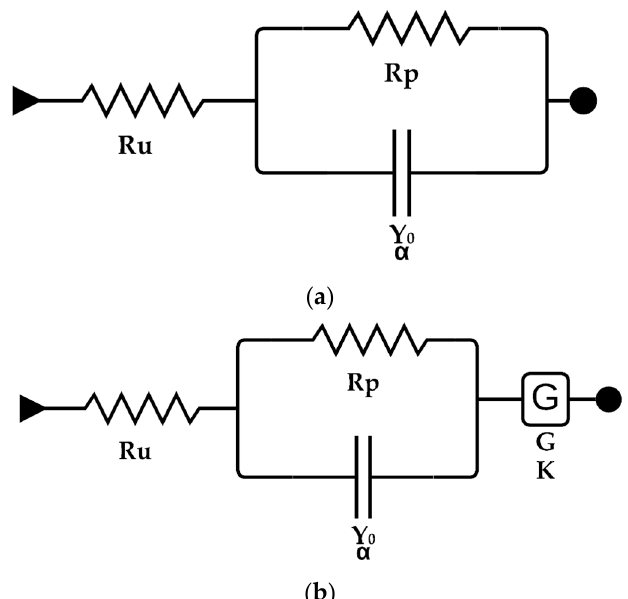
Figure 6. Equivalent circuits for ( a ) uncoated steel ( b ) coated steel.